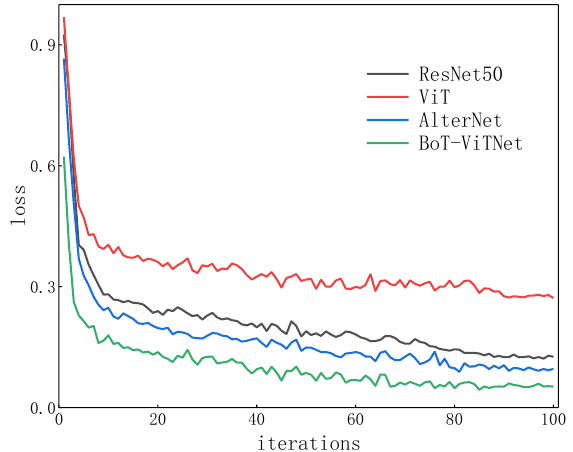
Figure 7. Loss variation curves of different models on the Coronahack dataset.